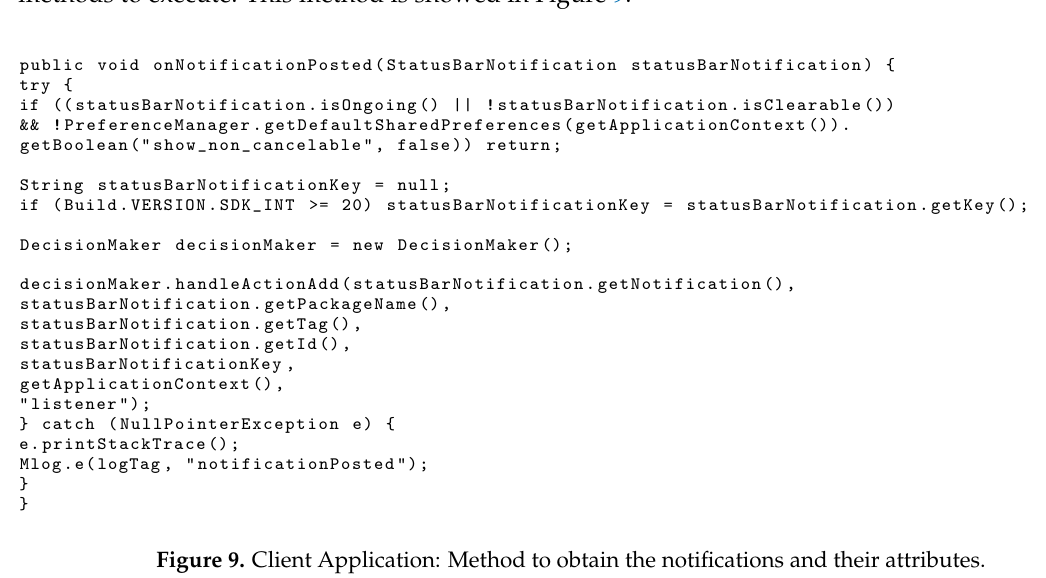
Figure 9. Client Application: Method to obtain the notifications and their